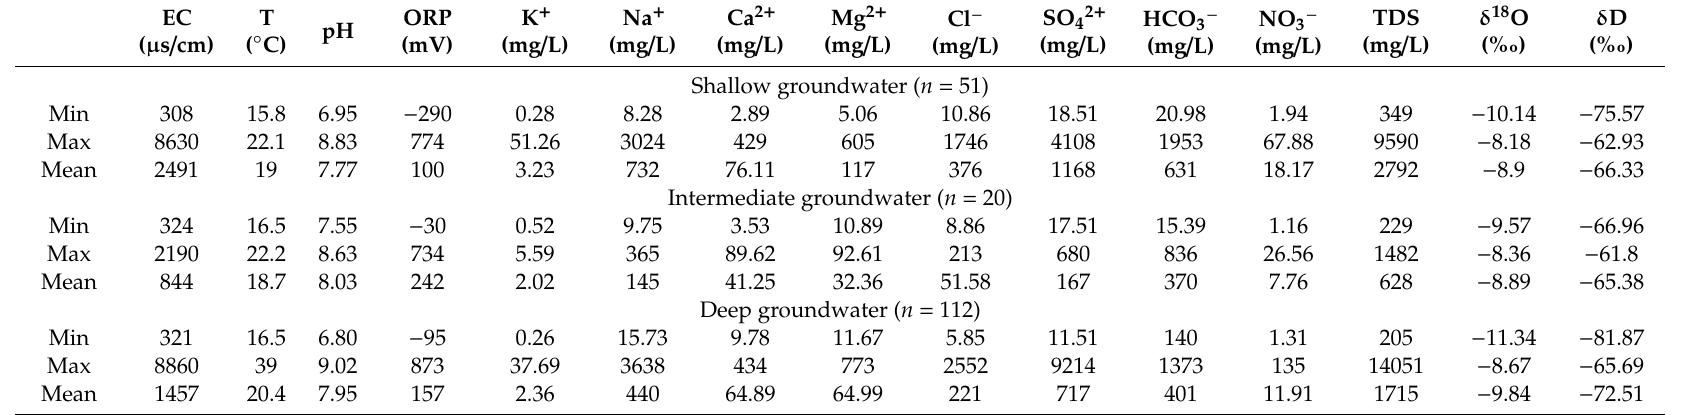
Table 1. Statistical summary of hydrochemical parameters of groundwater in Yuncheng